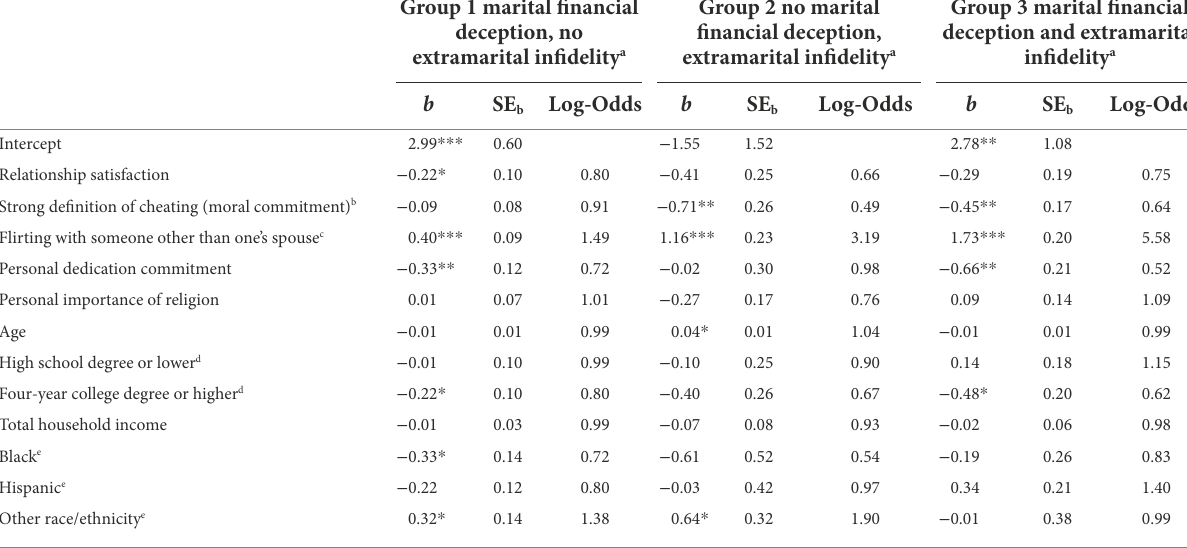
TABLE 2 Multinomial logistic regression predicting marital financial deception/extramarital infidelity group